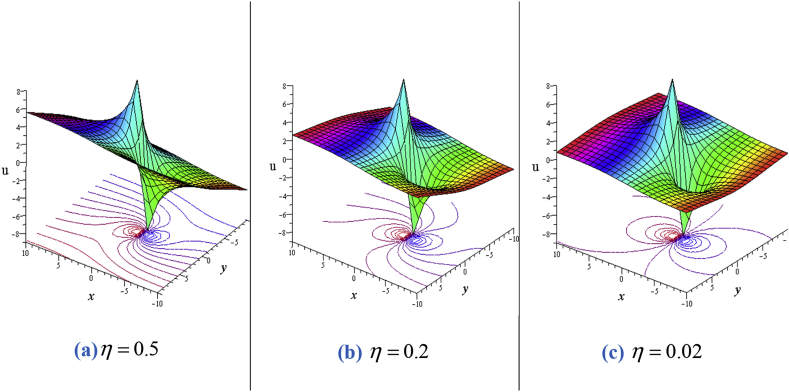
Profile of the Eq. (7) for ℓ1=ℓ4=ℓ6=ℓ8=ℓ9=1,σ=1,δ=0.3: 3D plot (upper) and corresponding contour plot (below) at t=0 where images (a) for η=0.5, (b) for η=0.2 and (c) for η=0.02.